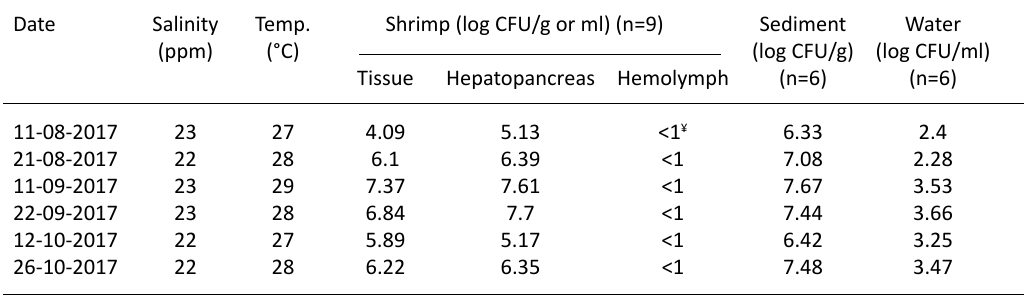
Table 3. Total Vibrio counts of the samples analyzed from the shrimp